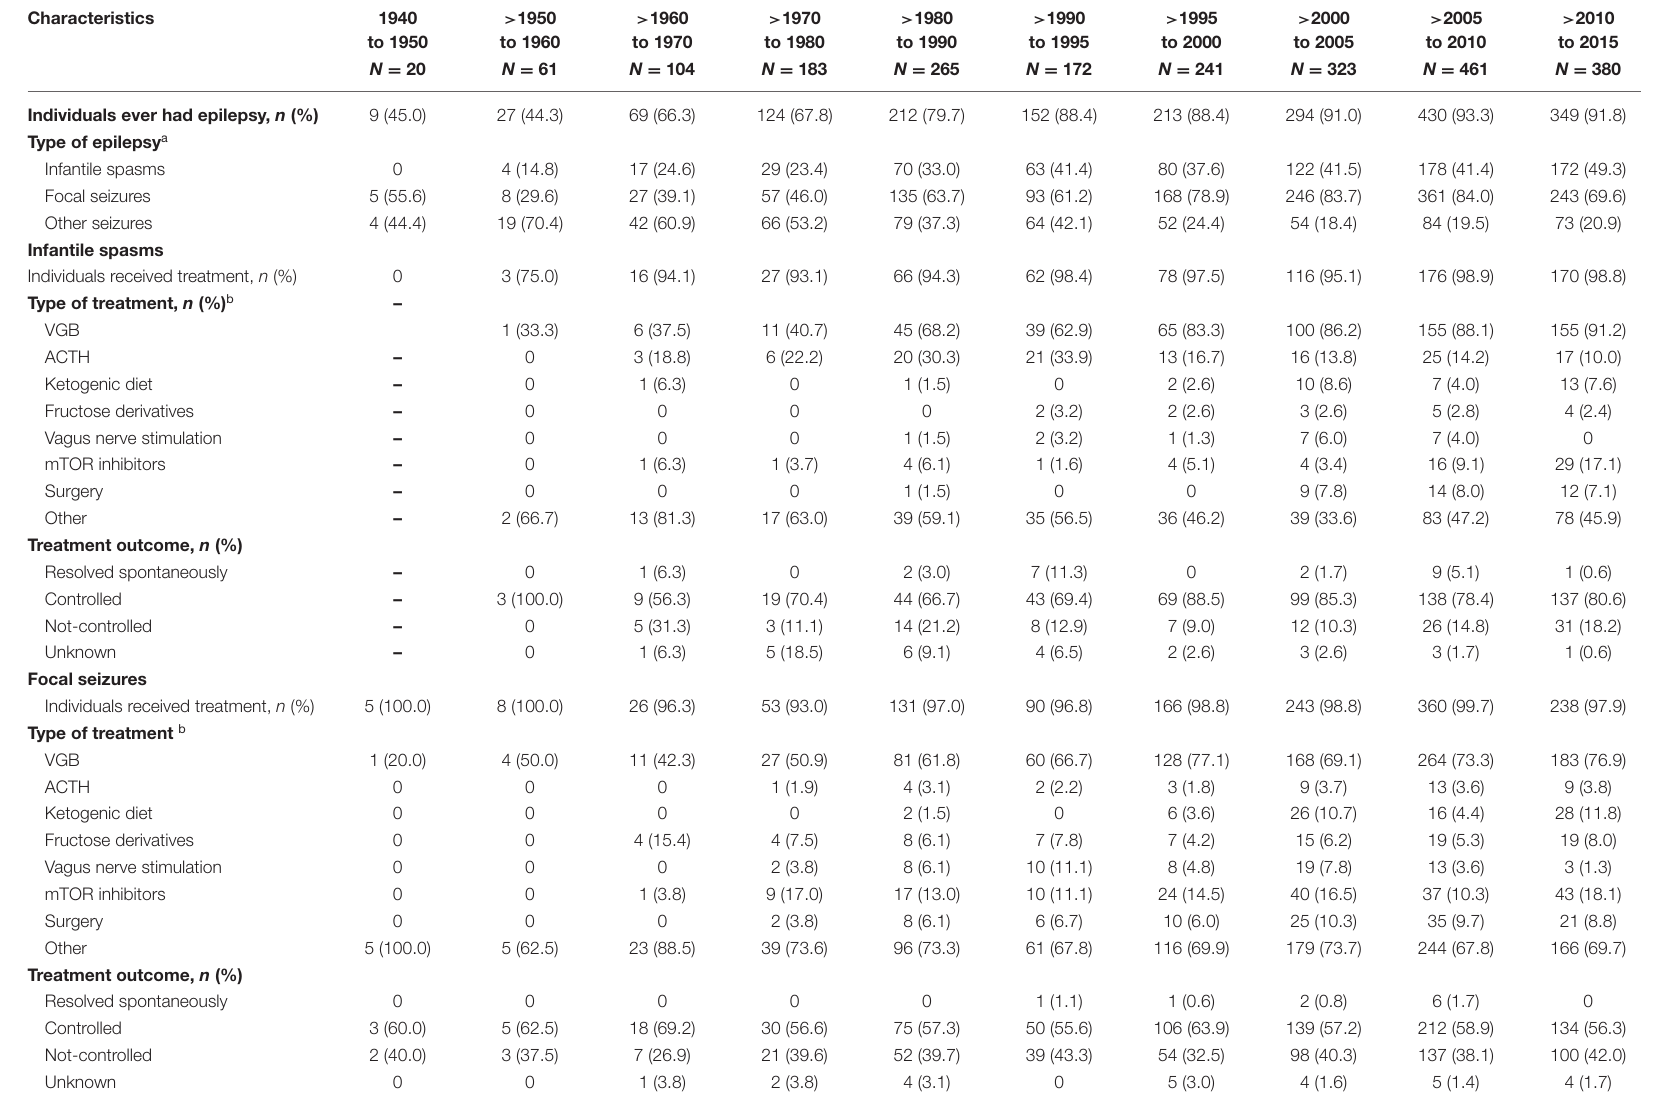
TABLE 2 | Rates of epilepsy and treatments over time among individuals with TSC and epilepsy.